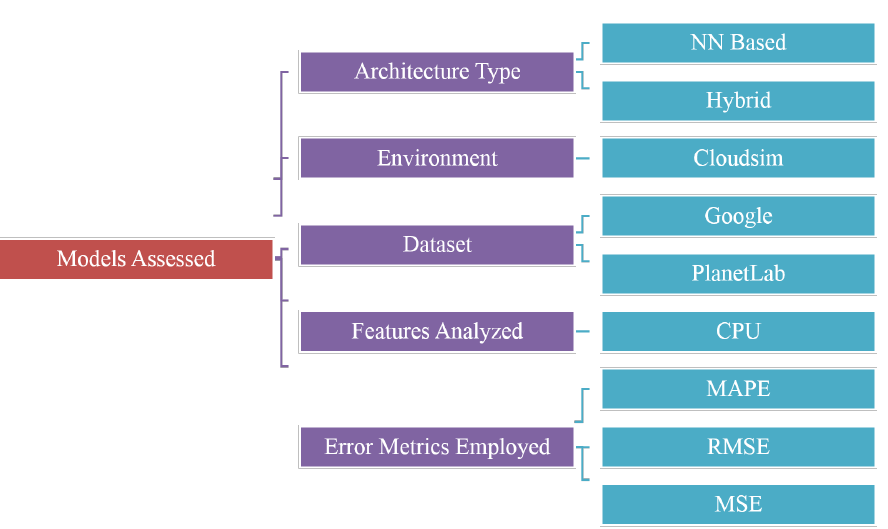
Figure 5. Classification of commonly employed